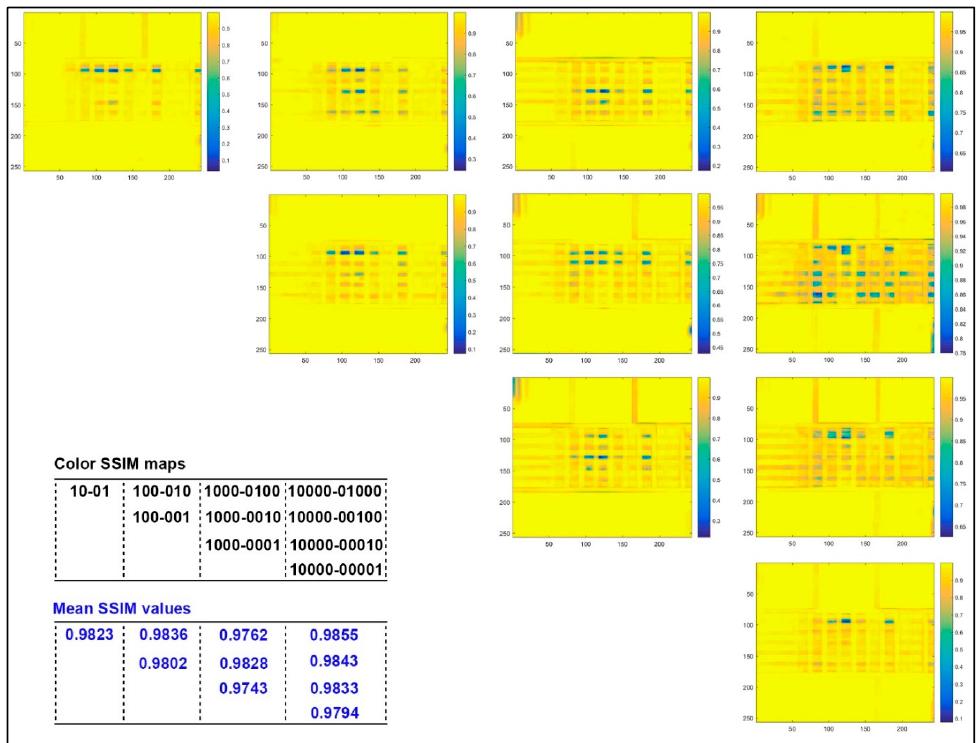
Figure 5. Color SSIM maps and MSSIM values for captured images of 3D color test charts compared with each other based on the same printing layers.